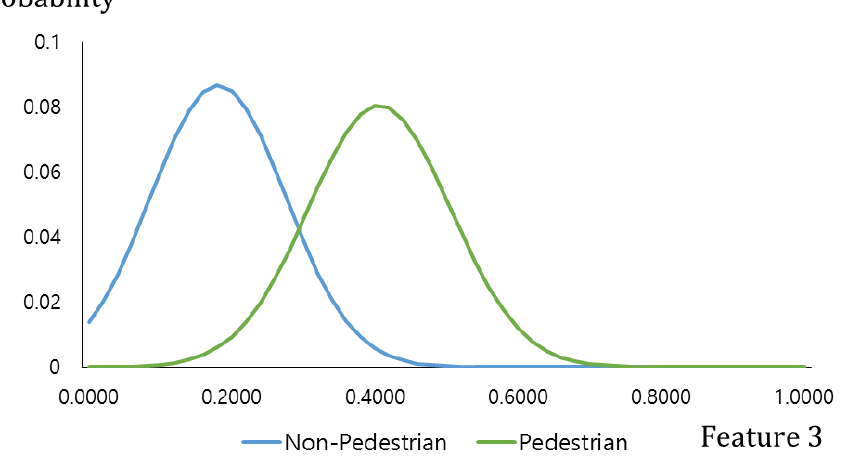
Figure 6. Data distribution pf feature 3.